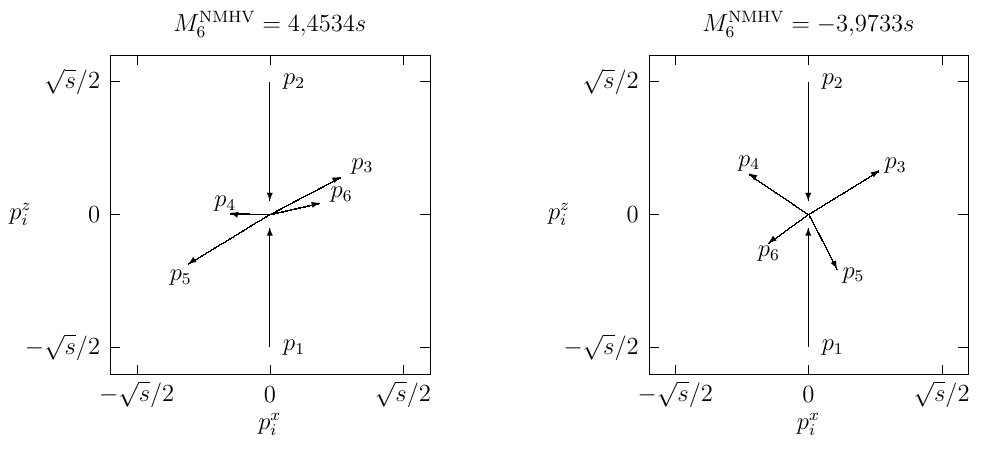
Fig. 1. Arbitrary NMHV n = 6 graviton processes for which the momentum planar Figure 2 . Two kinematic con(cid:12)gurations for which the planar, helicity preserving six-graviton configuration lead to a non-vanishing amplitude. amplitude in eq. (5.14) is